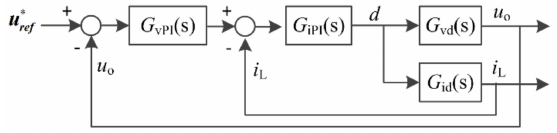
Figure A1. Block diagram of the voltage and current double-loop of boost